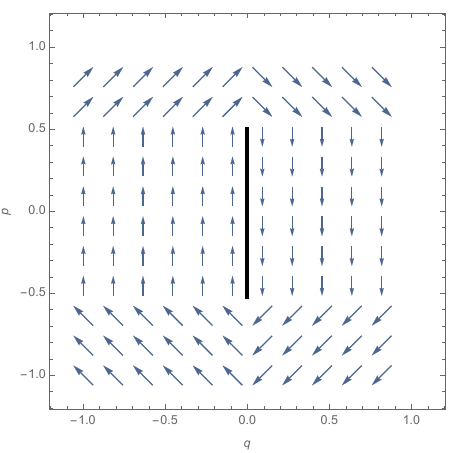
Figure 4. The folded string Hamiltonian flow in the ( p, q ) plane for the total momentum P = 1 . A solid line shows the discontinuity of the flow, which should be excluded from the phase